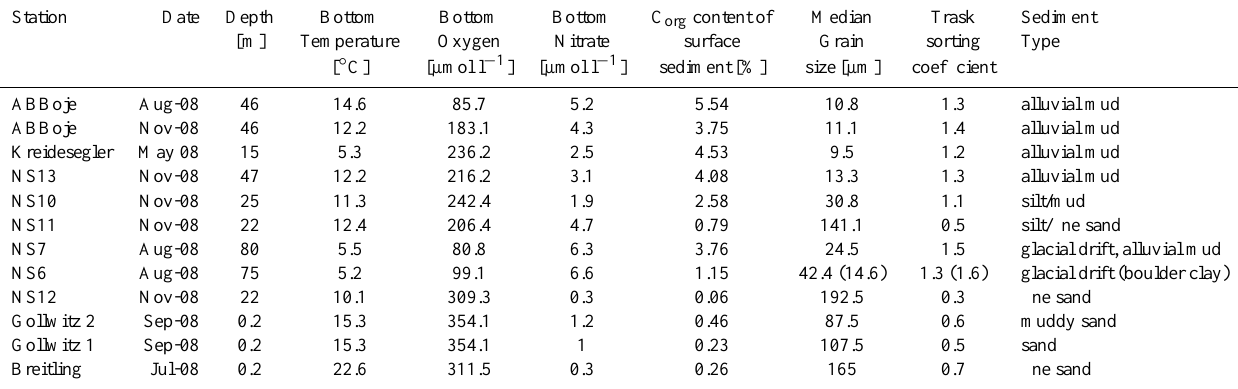
Table 2. Stations, sampling date, water depth, temperature, oxygen and nitrate concentrations of bottom water, organic carbon content of the surface sediments as well as median grain size, task sorting coefficient, and sediment type.